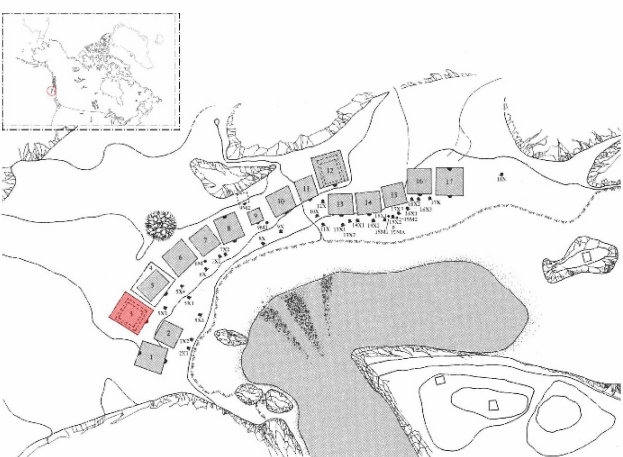
Figure 2. Plan of Ninstints (dwelling number 3 in red) based on [6] (p.